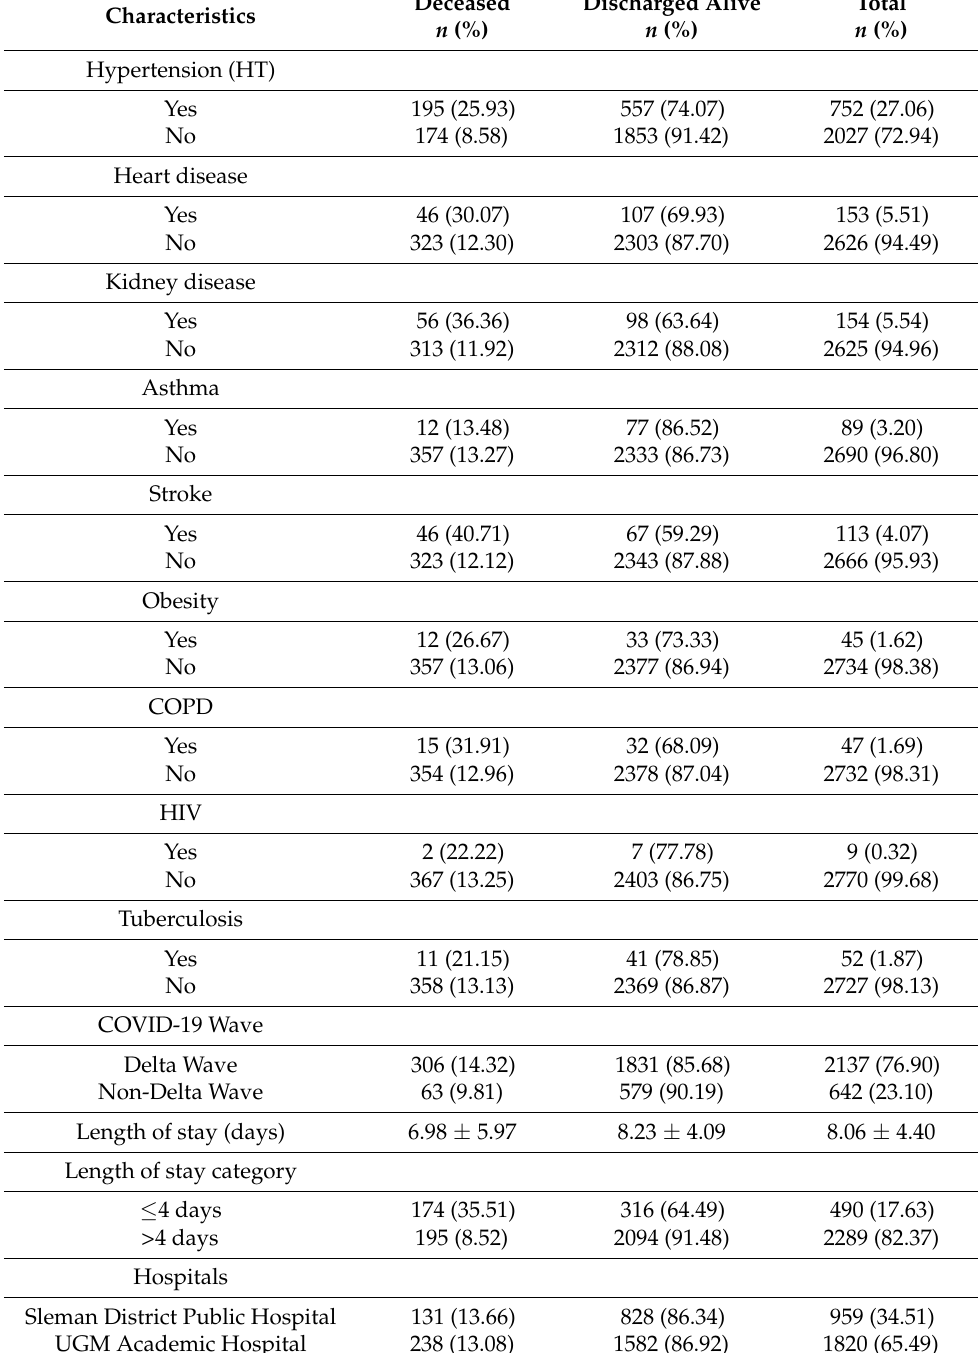
Table 1. Cont. Characteristics